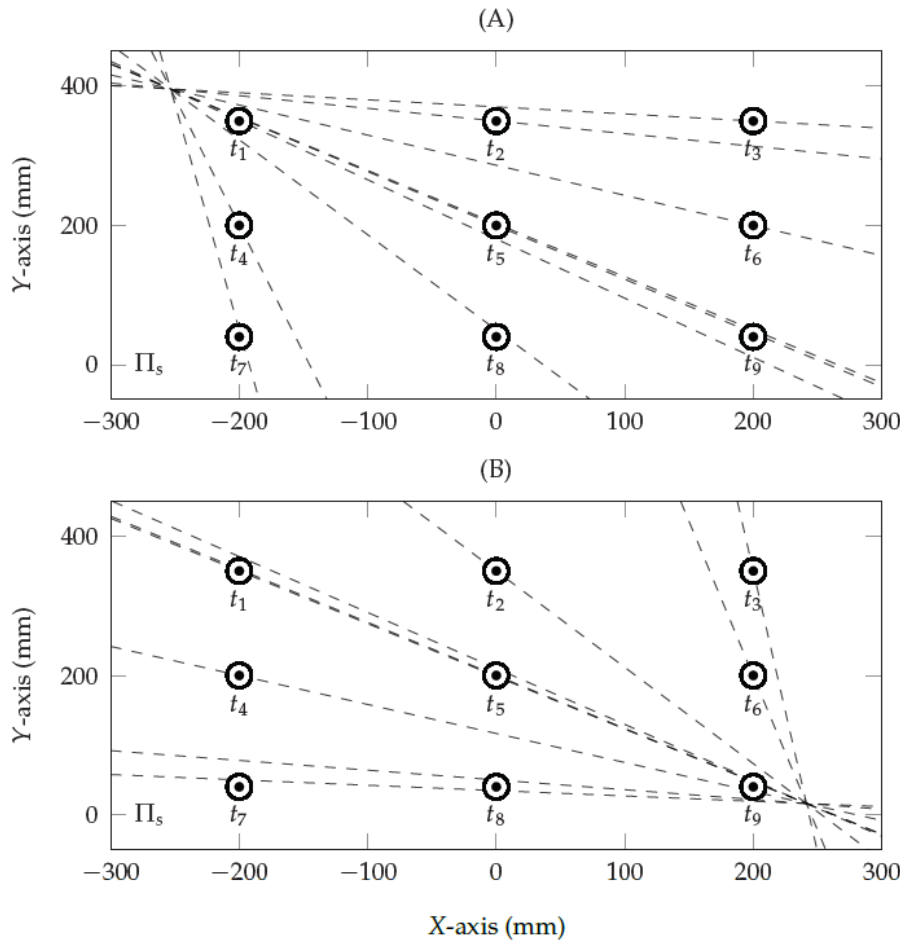
Figure 4. The epipolar geometry describes the eye-camera location in an eye tracker setup. The dots represent a set of 3 × 3 simulated targets of the gaze-mapping calibration. The epipolar lines pass through each calibration target and intercept at a common point, representing the eye-camera location related to the screen. In these simulations, the 3D eye-camera locations were ( A ) ( − 250,400,0 ) and ( B ) ( 250,0,0 )